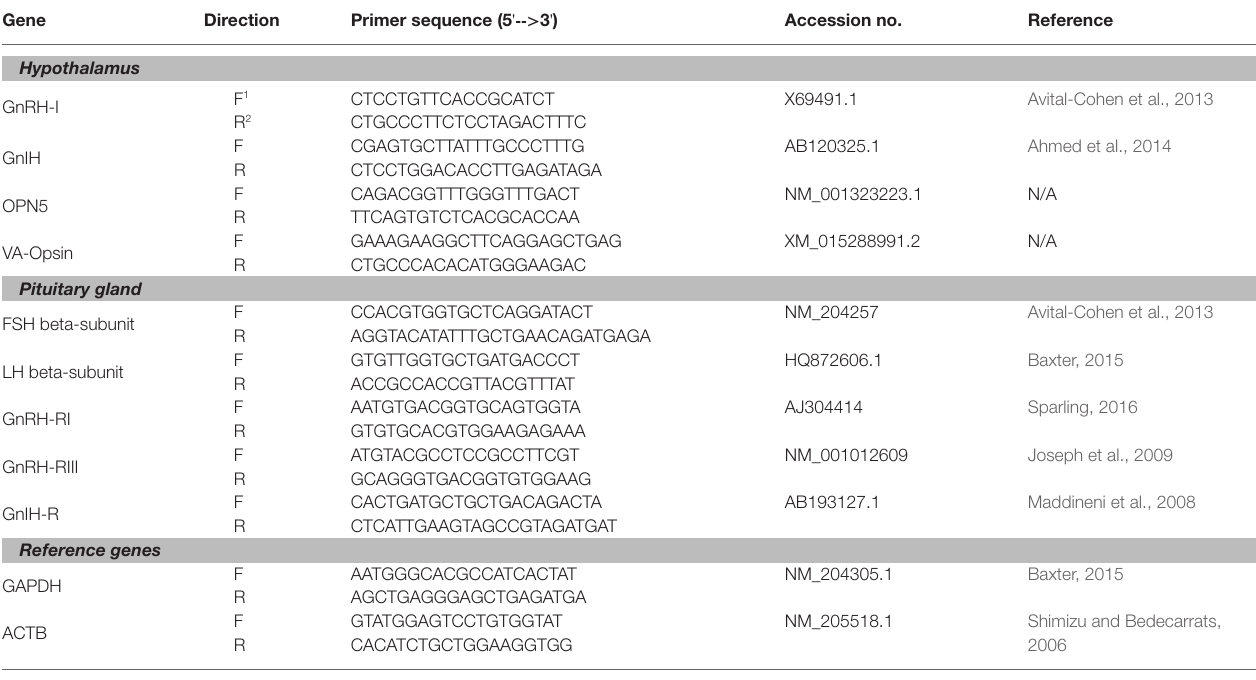
TABLE 1 | Primer list, including hypothalamic genes; GnRH-I, Gonadotrophin inhibitory hormone (GnIH), OPN5, and VA-Opsin, and pituitary genes; FSH beta-subunit, LH beta-subunit, GnRH-RI, GnRH-RIII, and GnIH-R, along with reference genes, glyceraldehyde 3-phosphate dehydrogenase (GAPDH) and beta-actin (ACTB).